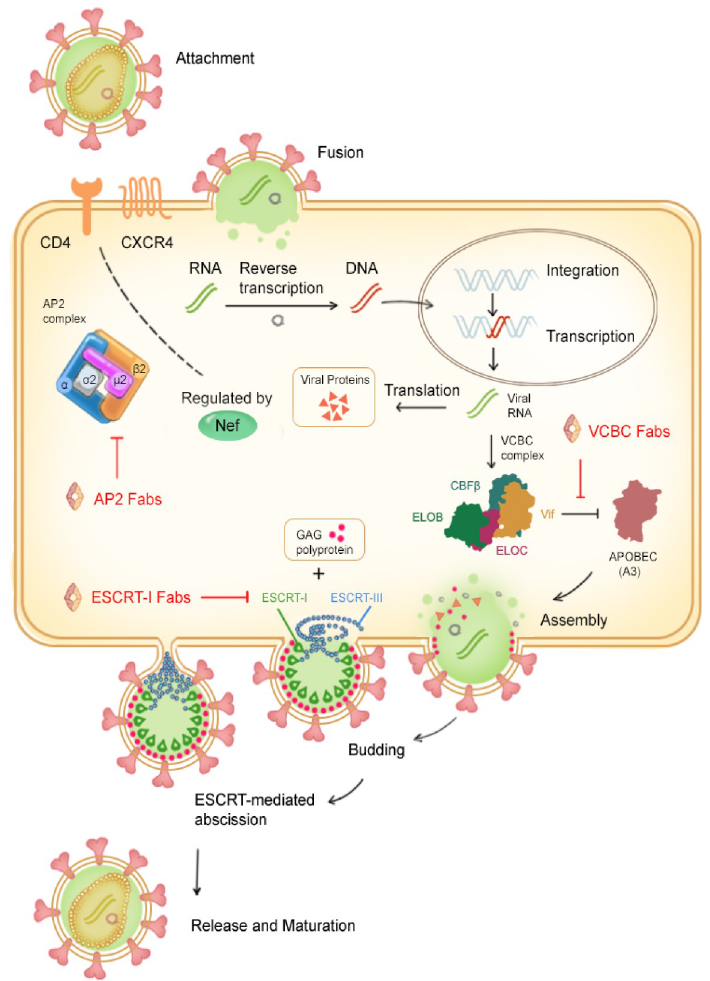
Fig 1. Three protein complexes essential for HIV replication targeted with recombinant antibodies. The antibodies described here are shown in